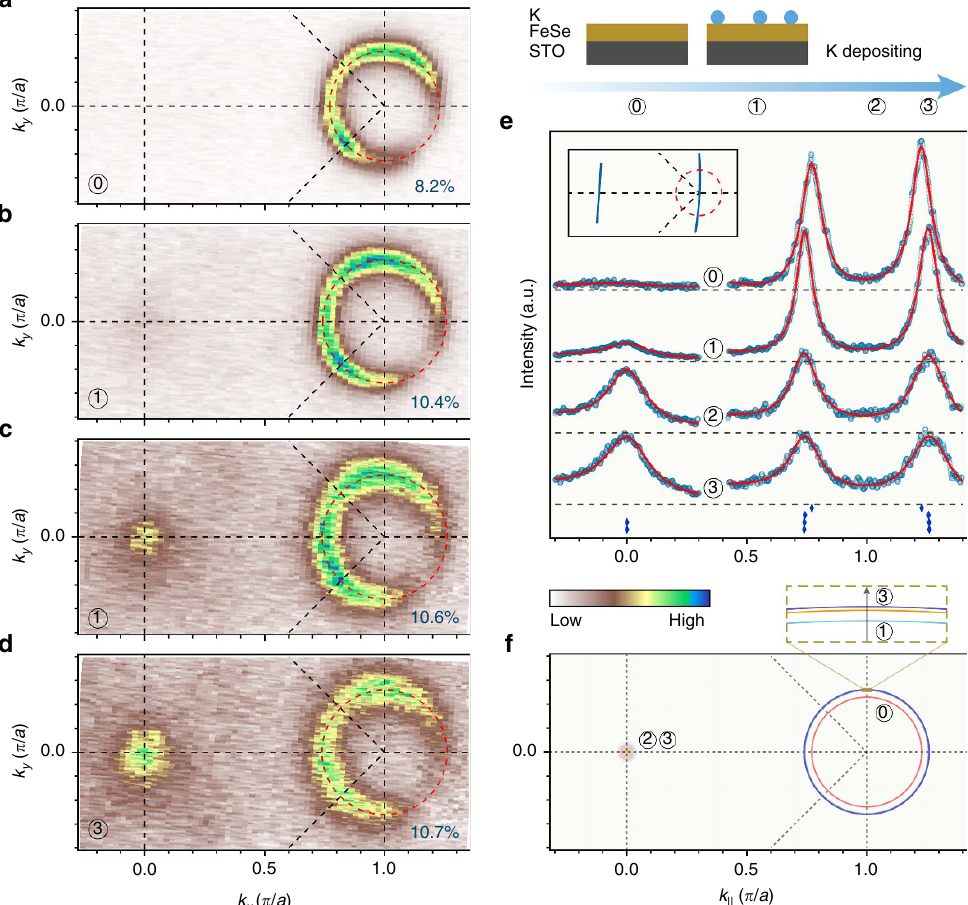
Figure 1 | FS evolution of potassium-coated 1UC FeSe/STO. ( a ) FS intensity map of a pristine sample recorded at 20K and integrated within a 20meV energy window with respect to E F . The doubly degenerate electron pocket occupies an area of B 8.2% of the whole BZ, thus giving an electron carrier concentration of 0.164 electrons per unit cell according to the Luttinger theorem. ( b – d ) Same as a but for the film after potassium was coated continuously. The percentages at the right bottom of each panel indicate the areas of the electron FS around M in the 1-Fe BZ. The size of the electron pocket at M is saturating slowly upon successive rounds of potassium deposition ( B 10.4%, B 10.6% and B 10.7% for the first, second and third rounds of deposition, respectively), but instead the spectrum gets broadened, due to the induced disorder at the surface. ( e ) Evolution of the momentum distribution curves along the high-symmetry cuts indicated in the inset upon potassium coating. The red curves correspond to fits of the data using multiple Lorentz functions. ( f ) Comparison of the FSs shown in a – d